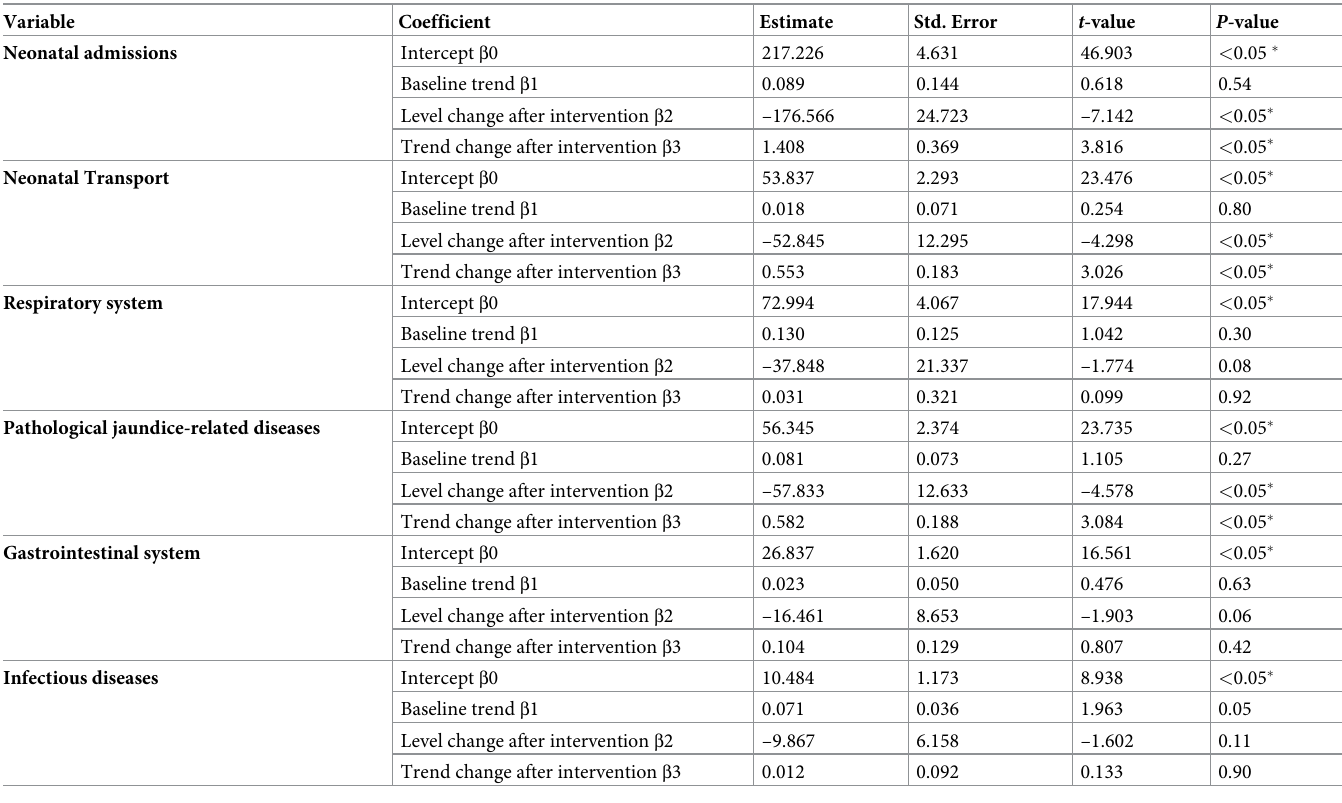
Table 2. Estimated coefficients of the segmented regression model for neonate admissions and disease spectra since January 4, 2019–August 27, 2020. Variable